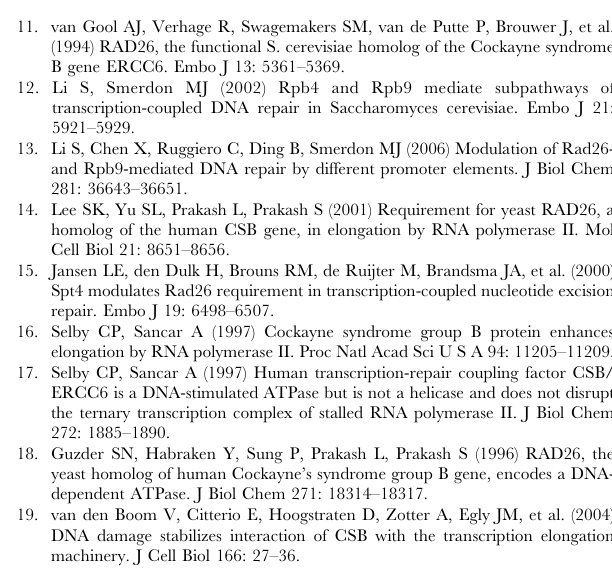
to ORF1, ORF2 and ORF3 of the RPL2B locus in WT, given for ORF1, ORF2 and ORF3 are calculated by normalizing the ChIP -PCR signal with the input PCR signal. The value for UV untreated cells was set as 1.0. For each strain, data represent the mean 6 1 SD for three independent